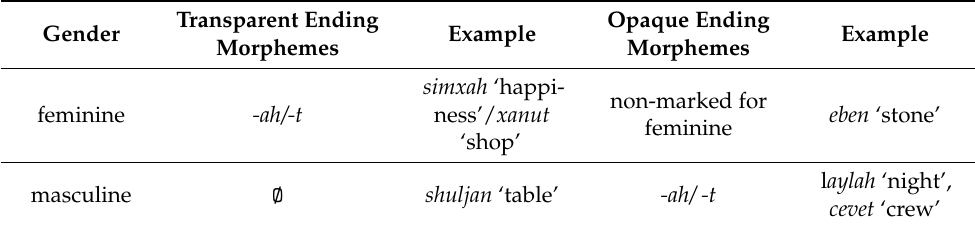
Table 4. Hebrew transparency/opacity singular noun gender system.